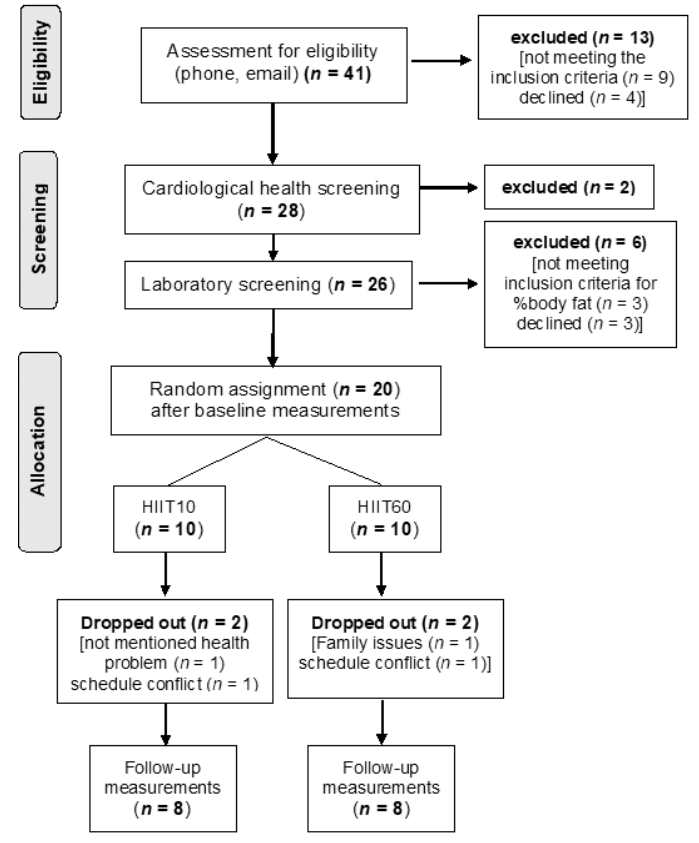
Figure 1. Flow diagram of the study design.